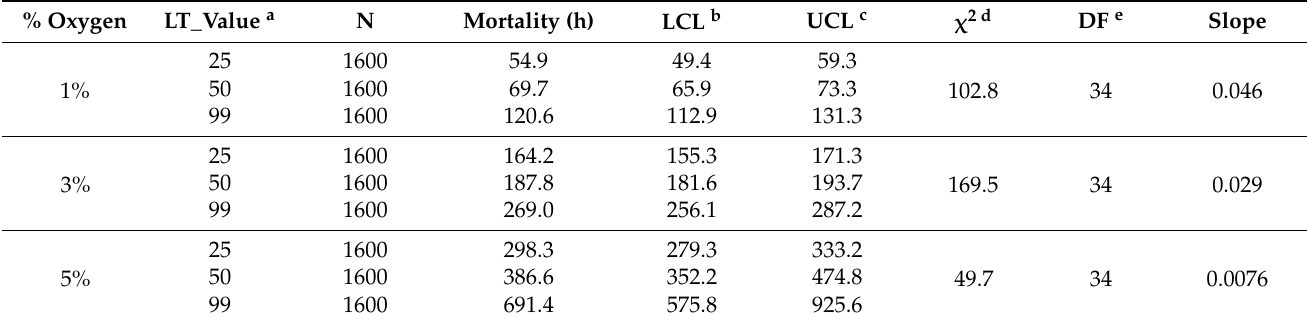
Table 2. Time mortality regressions for S. oryzae adults exposed to different oxygen levels.